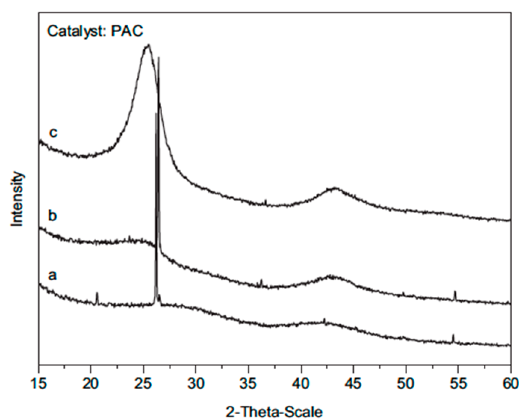
Figure 4. XRD spectra of AC samples: ( a ) fresh; ( b ) after reaction with pure methane at 850 °C; ( c ) after reaction with a mixture of 80% methane, 20% propylene at 850 °C [72].